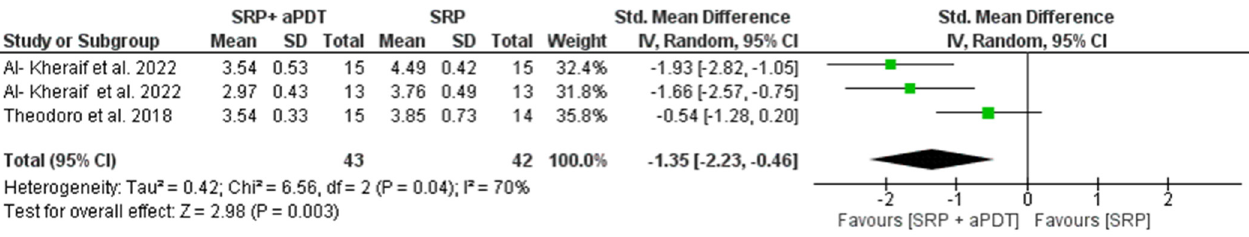
Figure 3. Forest plot of PD reduction at 6 months.